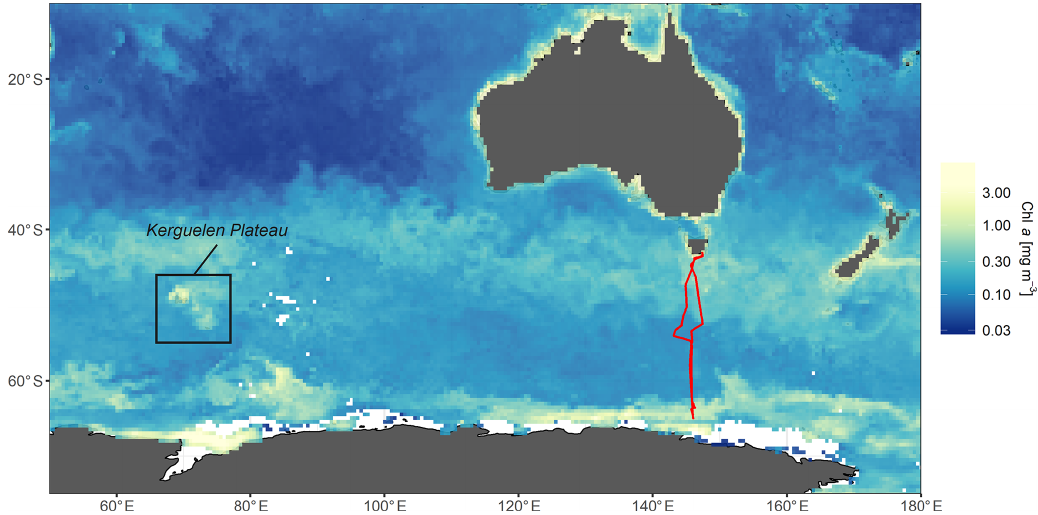
Figure 1. Voyage track (red line) of RV Investigator during the CWT voyage. The colour scale represents the mean chlorophyll a con- centrations for February 2015, derived from MODIS satellite images. A logarithmic scale has been used and has been limited to the range 0.03–7mgm − 3 to enhance visual detail. White regions represent unavailable data due to sea ice or persistent cloud cover, and a region of high marine biological activity has been marked in the vicinity of the Kerguelen